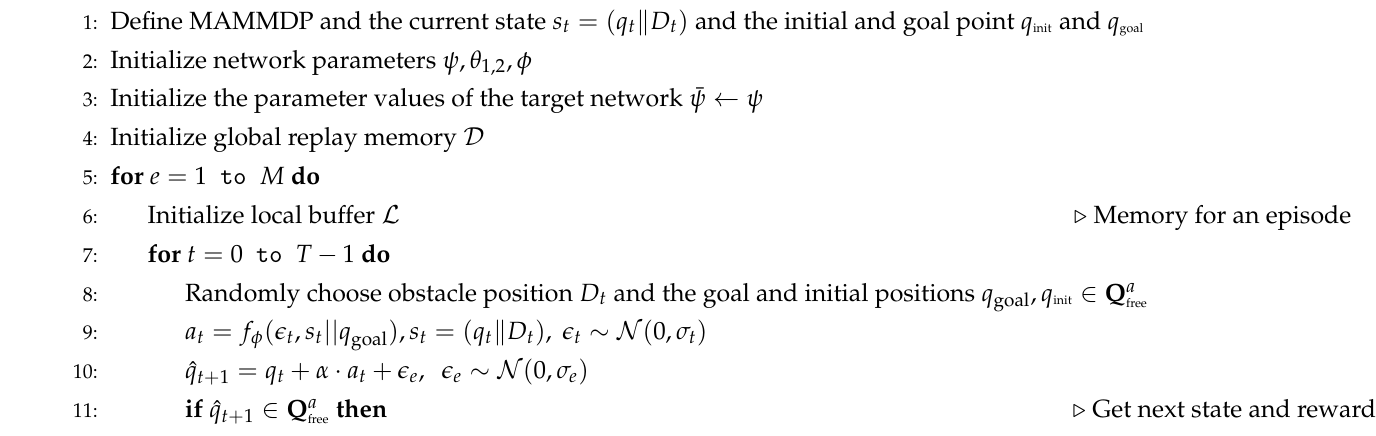
Algorithm 1 Proposed SAC-based path planning algorithm for multi-arm